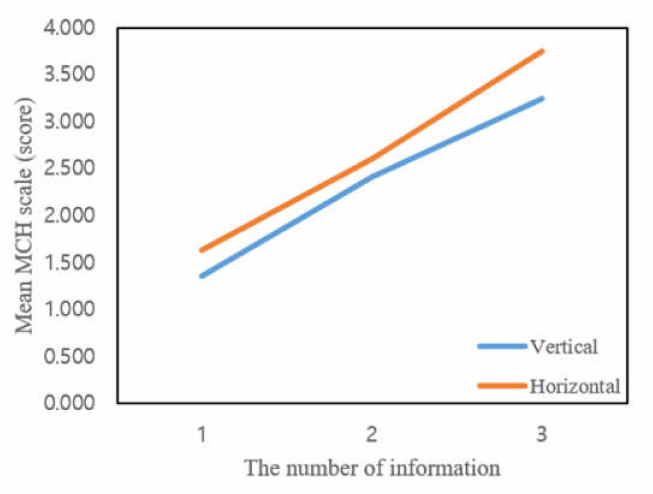
Figure 10. MCH scale according to the level of the number of information and arrangement of